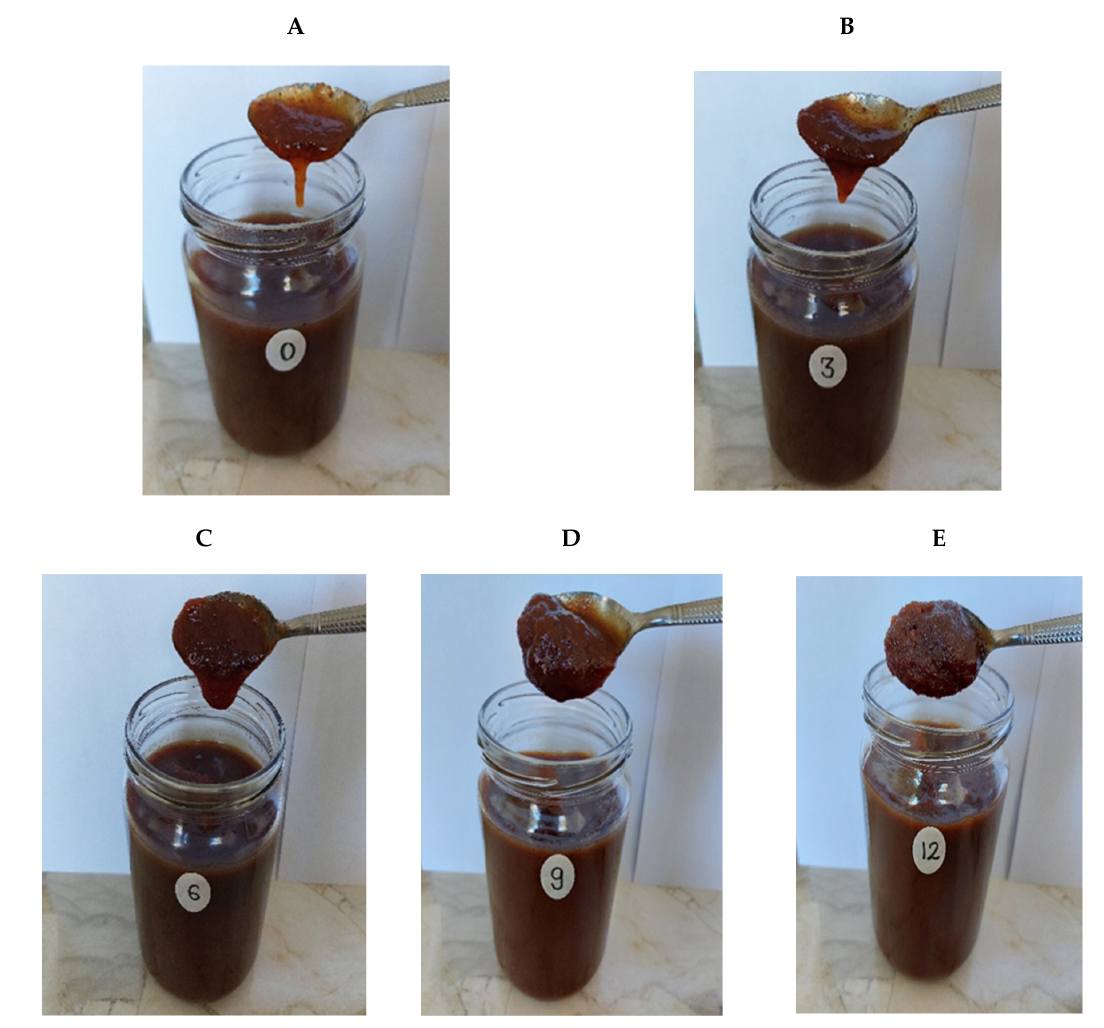
Figure 1. Date jam prepared with different amounts of powdered date press cake ( A : 0% DPC; B : 3% DPC; C : 6% DPC; D : 9% DPC; E : 12% DPC).